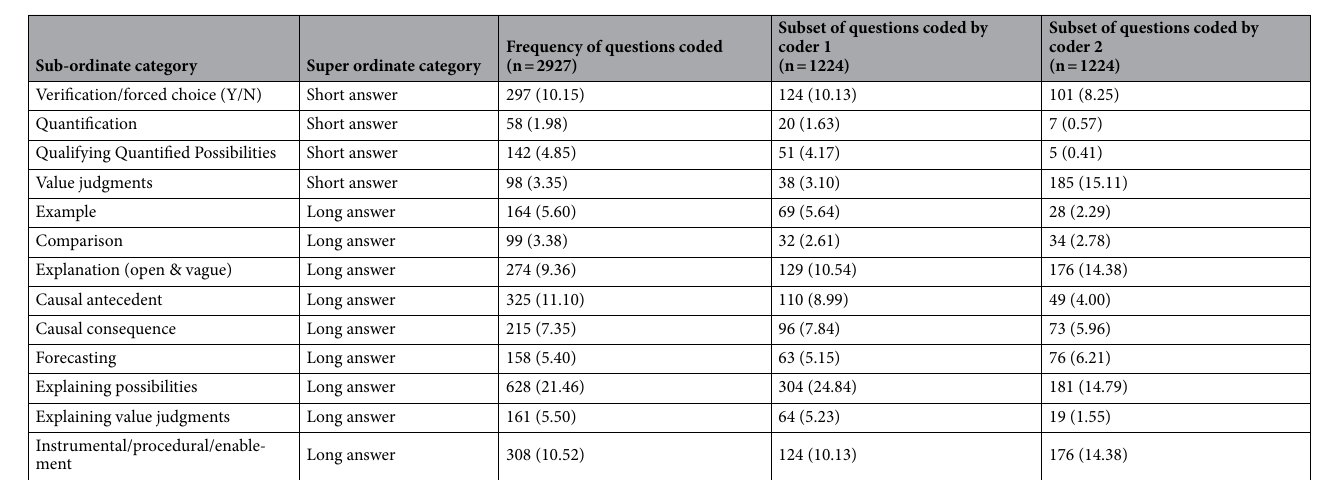
Table 4. Frequency (%) of questions when classified according to the Revised Taxonomy of Question Styles. This table shows the frequency of the questions coded into each question style category—in its initial application and by each coder—when using the Revised Taxonomy of Question